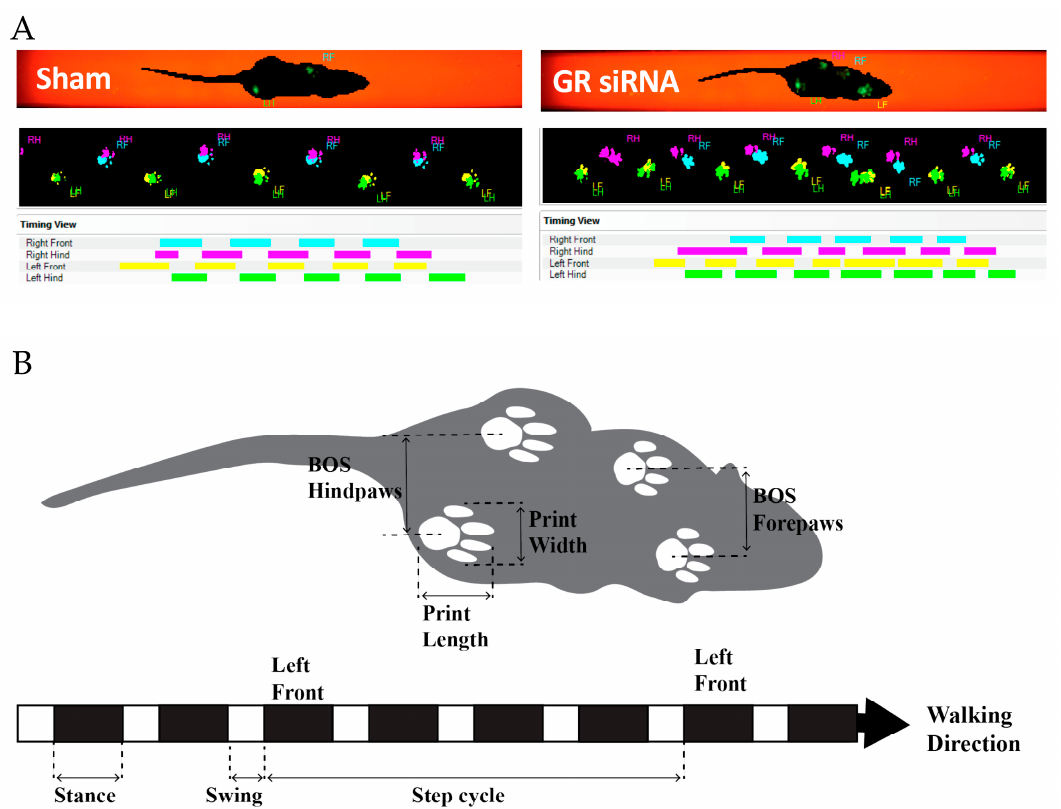
Figure 5. Schematic illustration of the CatWalk gait parameters. The CatWalk is a highly sensitive tool that analyzes the gait and locomotion of rodents. A camera detects the illuminated footprints and weight distribution on a glass plate. The animal traverses the glass plate to a goal box. ( A ) Two walking patterns were collected at five weeks post HI injury with GR siRNA treatment or sham. ( B ) A pictorial representation of the CatWalk parameters. The black boxes represent the stance, which is the duration of time a paw is in contact with the glass. The white boxes represent the swing duration of a paw when it is not in contact with the glass. A step cycle describes the time, in seconds, from when an initial paw contact on the glass to the next time the paw comes in contact with glass. Additional data is included in Supplemental Table S1.